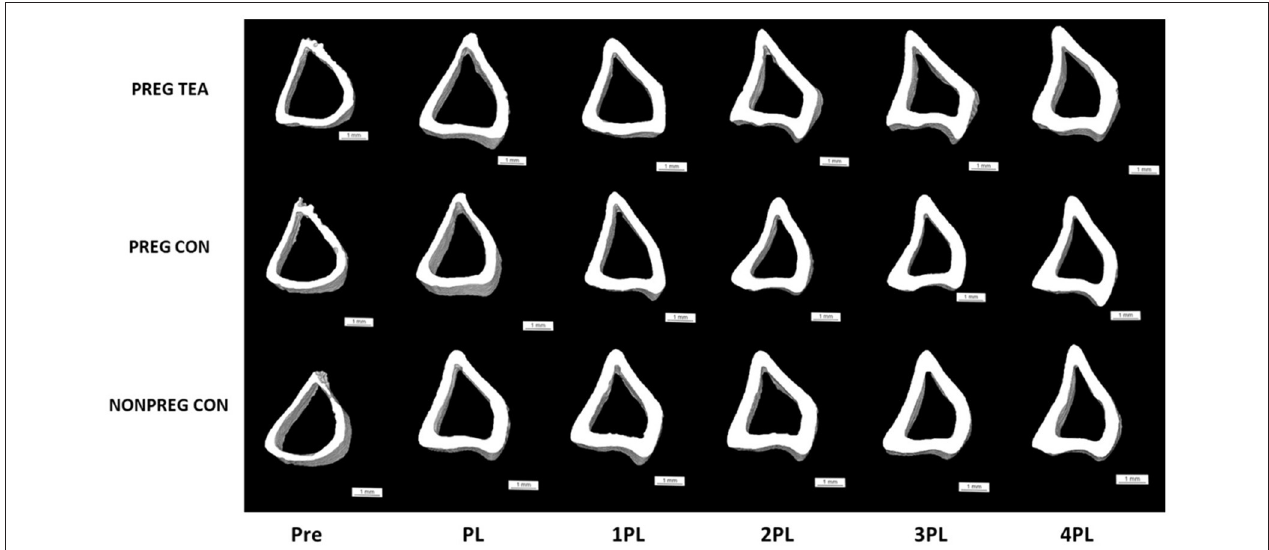
FIGURE 5 | Representative 3D images of cortical bone from right proximal tibia in female Sprague-Dawley rats pre-pregnancy, post-lactation, and 1, 2, 3, and 4 months post-lactation. Representative scans for each group are of the same rat at each time point and images were chosen by selecting the rat with the closest value for Ct.Ar/Tt.Ar to the group mean. Pre: pre-pregnancy, PL, post-lactation; 1PL, 1 month post-lactation; 2PL, 2 months post-lactation; 3PL, 3 months post-lactation; and 4PL, 4 months post-lactation. The white bar under each scan represents a length of